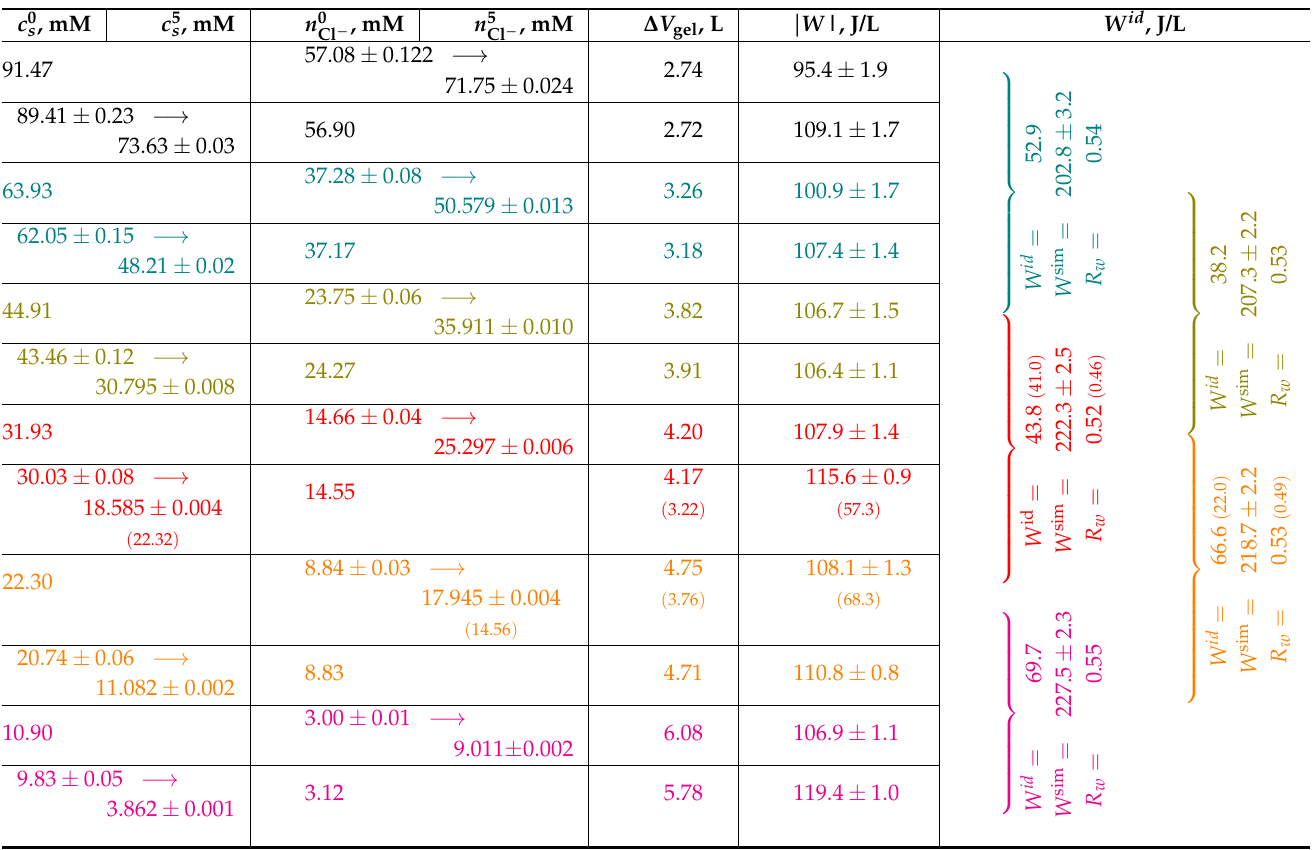
Table 1. Estimates of desalination efficiency. All units are calculated per one mol of gel segments. Values in brackets correspond to crossection of ‘red’ and ‘orange’ lines on the plots in Figures 2 and